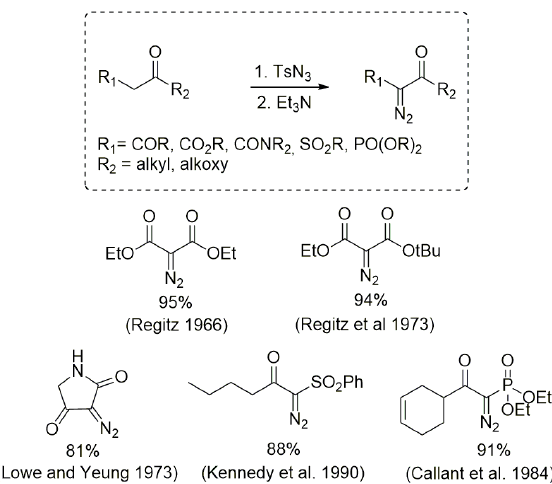
Figure 17 - Preparation of diazocarbonyl compounds by simple diazo transfer reaction.